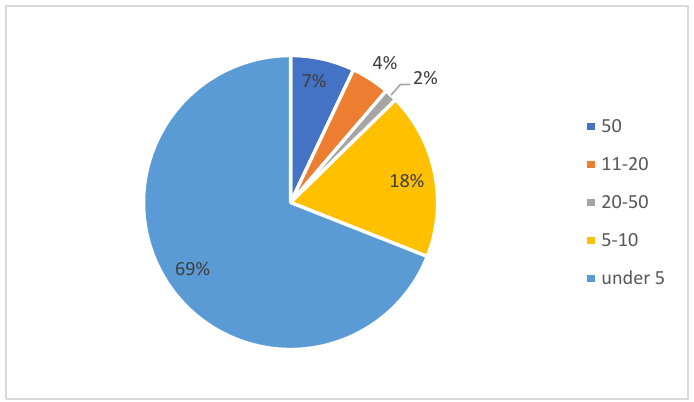
Figure 2. Split of transporters according to fleet dimension.